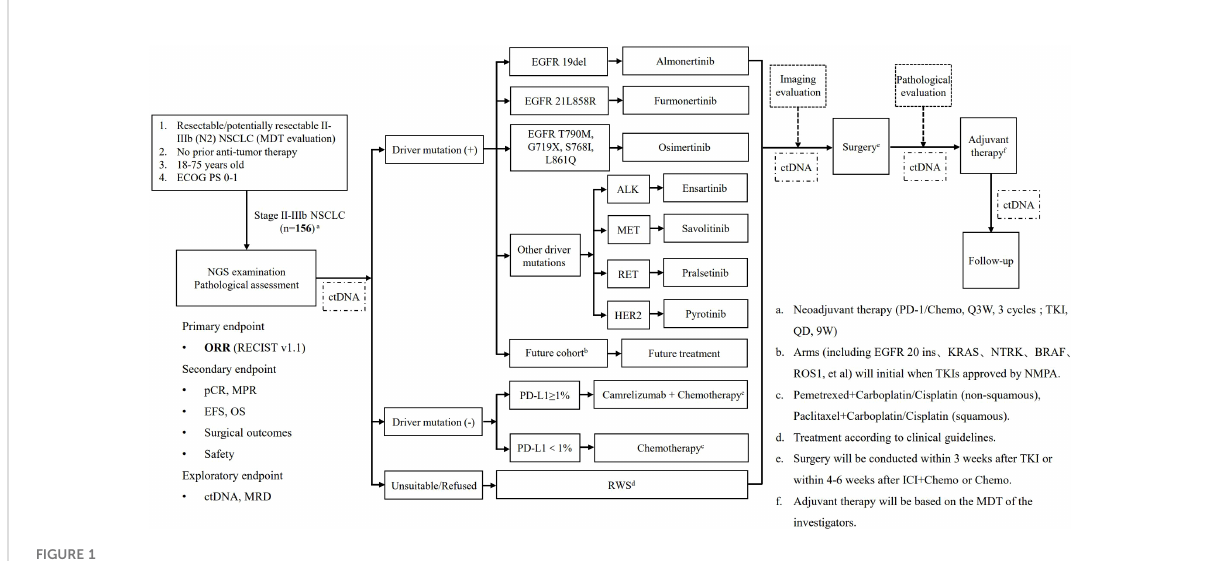
FIGURE 1 The study fl